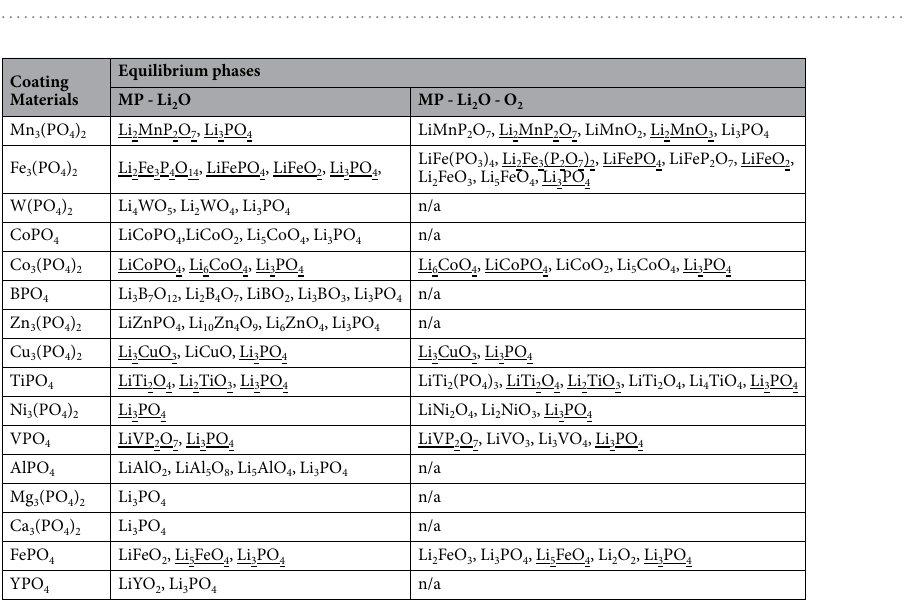
Figure 5. ( a , d ) Phase diagram, ( b , e ) equilibrium phase information, and ( c , f ) XRD pattern of Co 3 (PO 4 ) 2 and Mn 3 (PO 4 ) 2 coating materials after reacting with Li residue (black) and peak information of the discovered phase. Blue and red circles in the phase diagram represent the stable phase and the stable phase confirmed from XRD analysis, respectively.